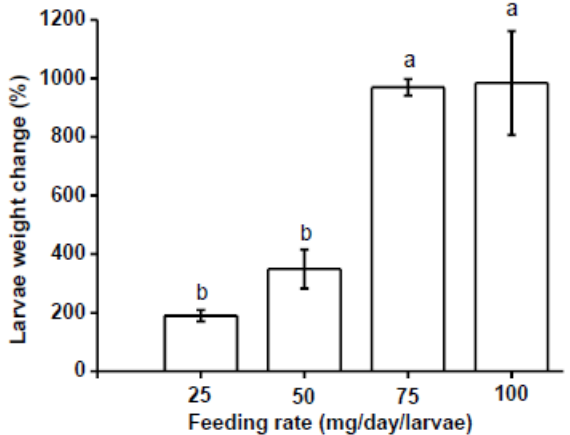
Figure 10. Effect of different daily feeding rates on black soldier fly larvae weight change. Data indicate mean and its standard deviation of triplicates. Bars without the same lowercase letter(s) differ significantly ( p < 0.05).